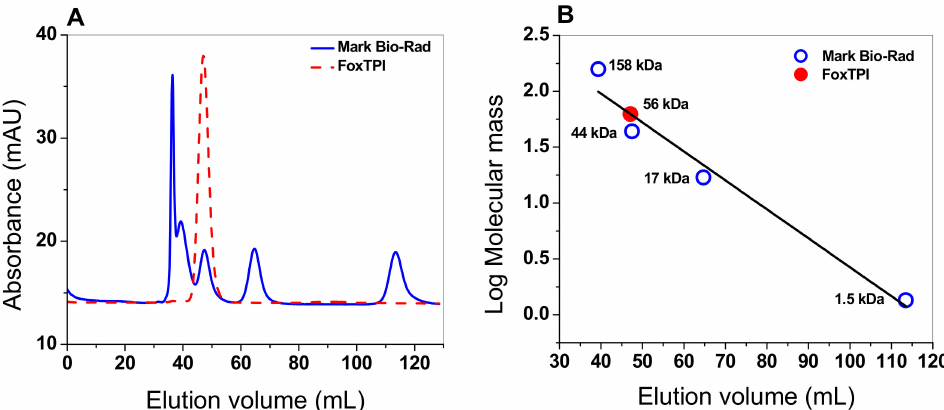
Figure 4. Oligomeric status of the recombinant FoxTPI protein. ( A ) size exclusion chromatography of FoxTPI and gel filtration standard from BioRad, containing thyroglobulin, γ -globulin, ovalbumin, and vitamin B12. The red line represents the recombinant FoxTPI; ( B ) calibration curve of marker proteins drawn with elution volumes versus log of molecular mass (MW) of Bio-Rad’s gel filtration standard (blue spots). The MW of FoxTPI (red circle) is shown on the straight line